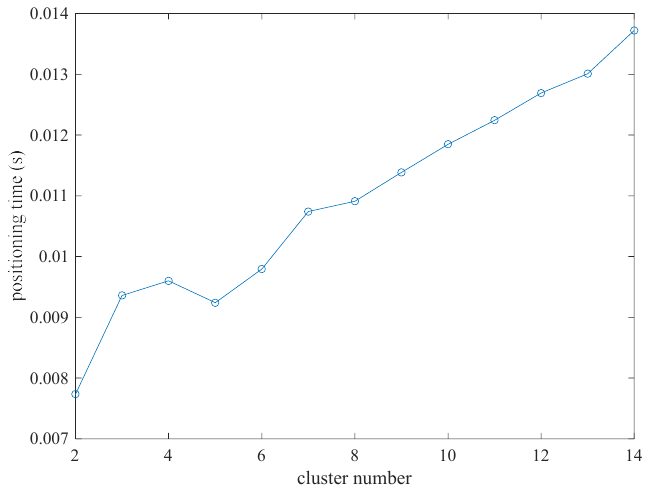
14 of 23 Figure 9. The positioning error changes with different cluster number. We record the positioning processing time with different cluster numbers in Figure